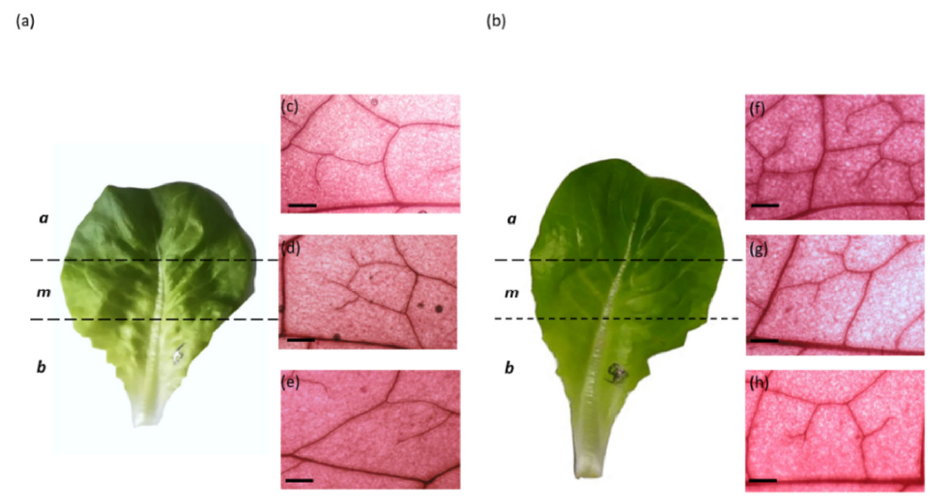
Figure 5. Schematic representation of leaf visual division into three portions: bottom ( e , h ), middle ( d , g ) and apex ( c , f ), from a representative plant grown under ( a ) high and ( b ) low VPD. Representative micrographs of leaf veins for both conditions are shown. Scale bars: 500 µm.